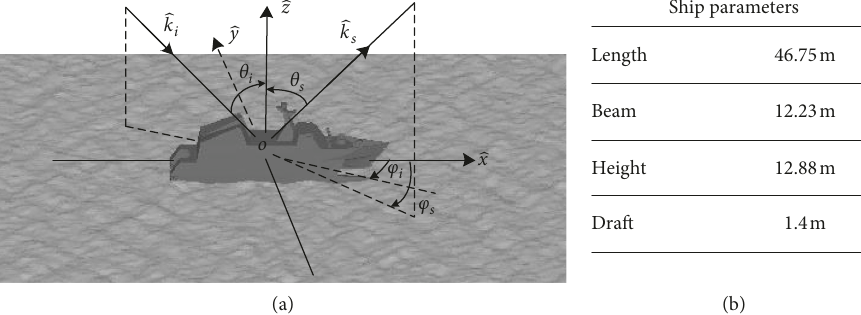
Figure 7: The geometry of the ship and the composite scattering coordinate system of the composite